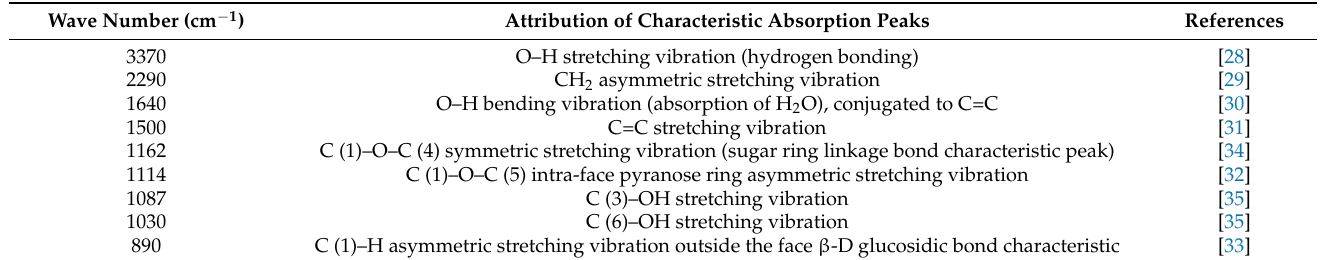
Table 2. Characteristic peaks of some groups in the infrared